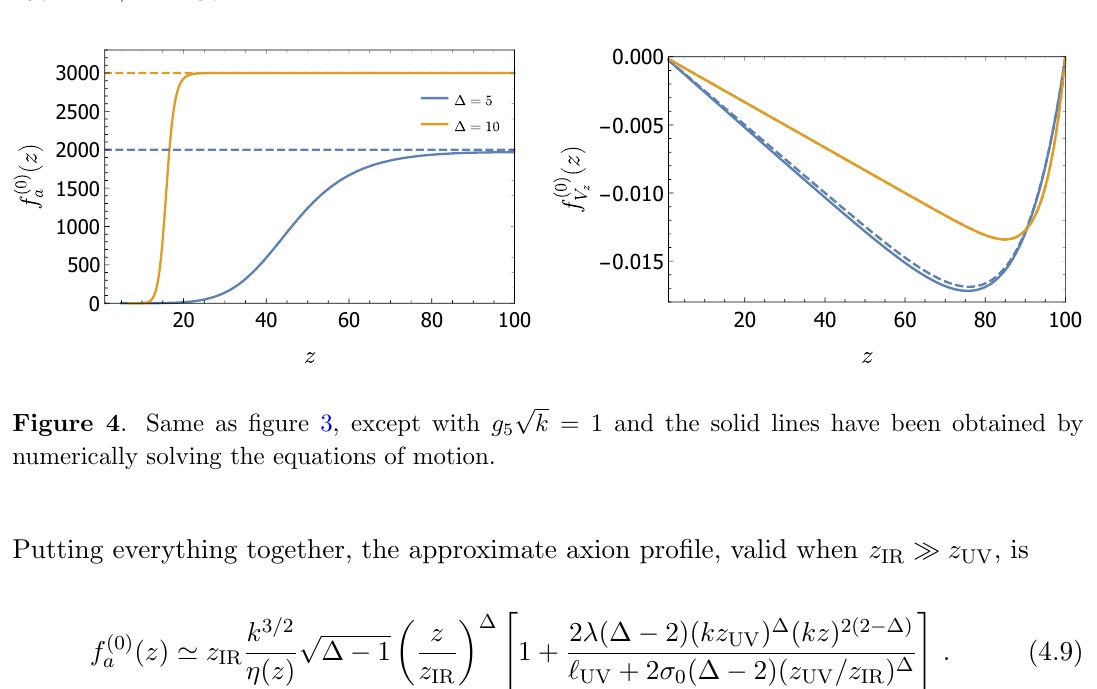
Figure 3 . Normalised axion pro(cid:12)le with explicit U(1) PQ breaking UV boundary term. The solid lines show the approximate pro(cid:12)le in eq. (4.9), while the dashed lines show the massless ( ‘ UV = (cid:21) = 0) solution (3.5) for comparison. We (cid:12)xed k = 1, kz UV = 1, kz IR = 100, (cid:27) 0 = 0 : 1, ‘ UV = 0 : 1, and b UV = 0.